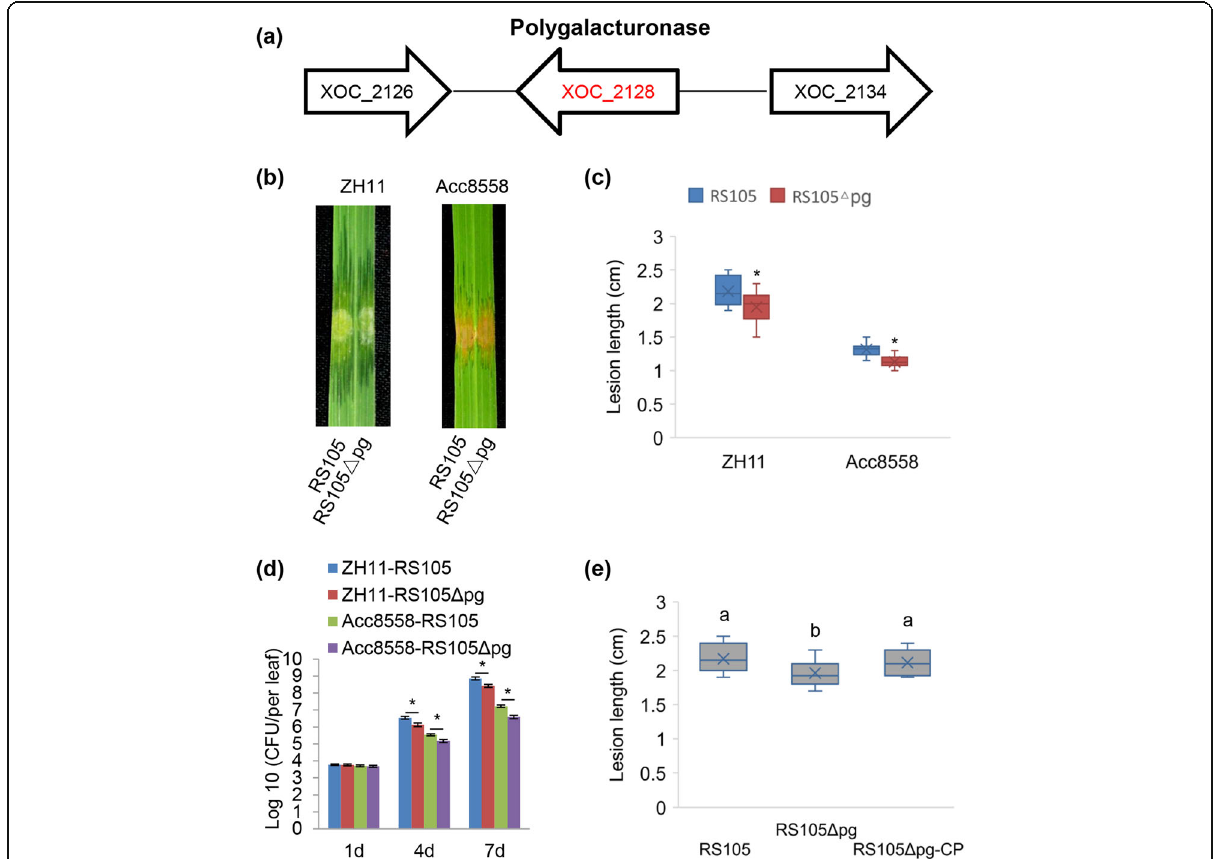
Fig. 3 The polygalacturonase gene acts as a virulence factor of RS105 during infection in rice. a The position of the polygalacturonase ( PG ) gene in the Xoc RS105 genome. b The phenotype of RS105 and the PG mutant strain (RS105 Δ pg) on the susceptible rice variety ZH11 and moderately resistant variety Acc8558. Images were photographed 14 days after inoculation. c The statistical counting of lesion length at 14 days after inoculation with RS105 and RS105 Δ pg on ZH11 and Acc8558. The data were counted from over 10 plants and analyzed using a t -test ( P < 0.05). Asterisks represent statistically significant differences from ZH11. d The bacterial growth curves of RS105 and RS105 Δ pg in ZH11 and Acc8558 rice at 1, 4, and 7 days. Significant differences were determined by t test: *P < 0.05. e Lesion length after inoculation with RS105, RS105 Δ pg and PG gene complementary stain (RS105 Δ pg-CP) at 14 days in ZH11. The letters above the bars represent the significant differences at a value of P ≤ 0.05 (LSD test). The above experiments were repeated three times with similar